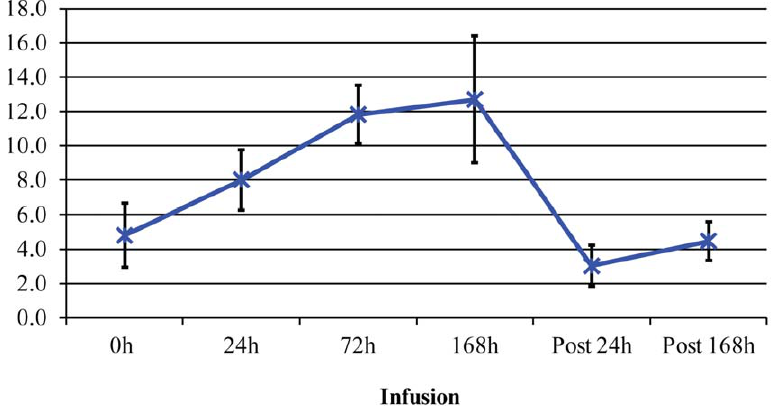
Figure 1. Butyrate molar percentages in the rumen of dairy cows in response to ruminal butyrate infusion. Error bars=SD. Post24 h and Post168 h=24 h and 168 h after infusion withdrawal, respectively.